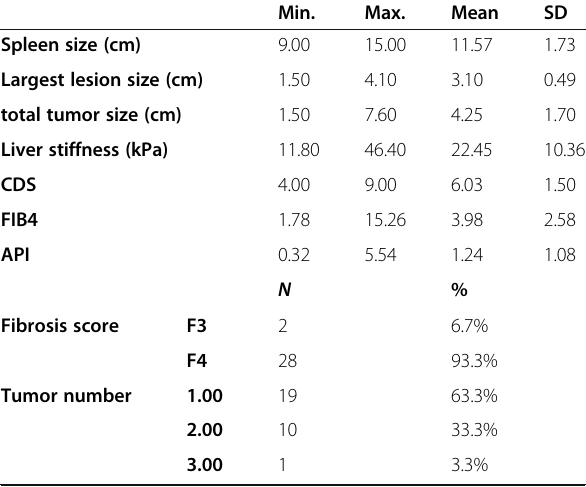
Table 1 Baseline radiological assessment, liver stiffness, and noninvasive serological